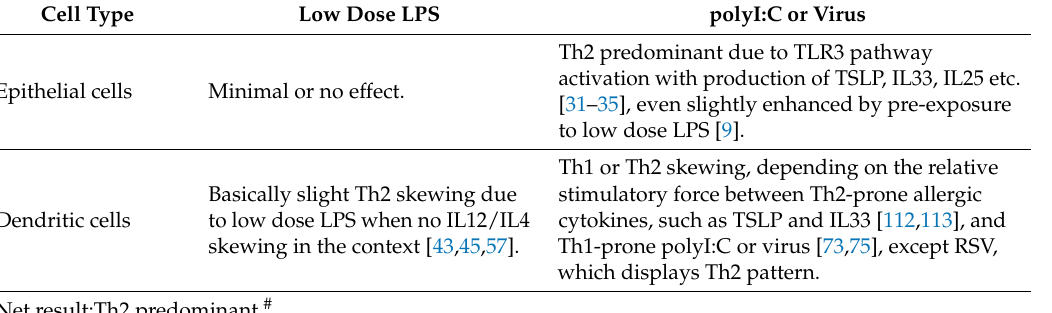
Table 5. Profile of four major players of the hygiene hypothesis model in the presence of low dose LPS before